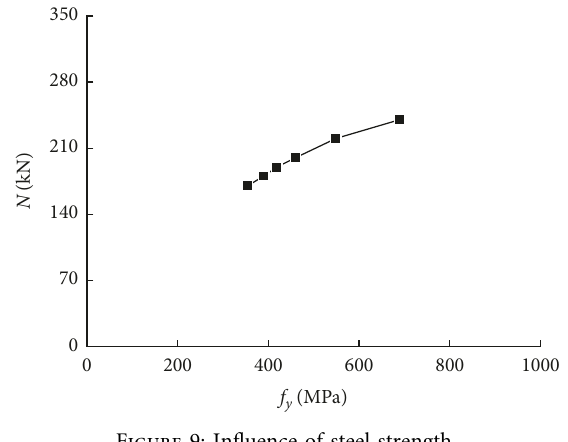
Figure 9: Influence of steel strength.